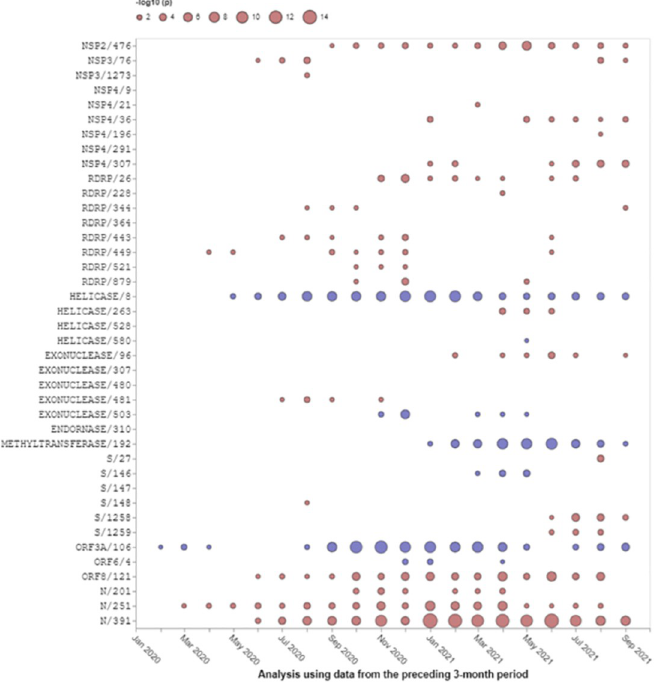
Fig 3. Evolutionary trajectories of 40 high-priority selected sites (from Table 4). If a site was found to be positively (red) or negatively (blue) selected during a specific time, a bubble will be drawn at a corresponding point on the plot. The area of the bubble is scaled as -log10 p, where p is the p-value of the FEL likelihood ratio test. Larger bubbles correspond to smaller p-values; p-values are not directly comparable between different time windows and different genes due to differences in sample sizes and other factors. The x-axis shows the endpoint of the time-window, e.g., March 30th, 2021, will correspond to the analysis performed with the data from January 1, 2021, to March 30, 2021. Figures like this can be generated with the “Evidence of natural selection history operating on SARS-CoV-2 genomes” ObservableHQ notebook